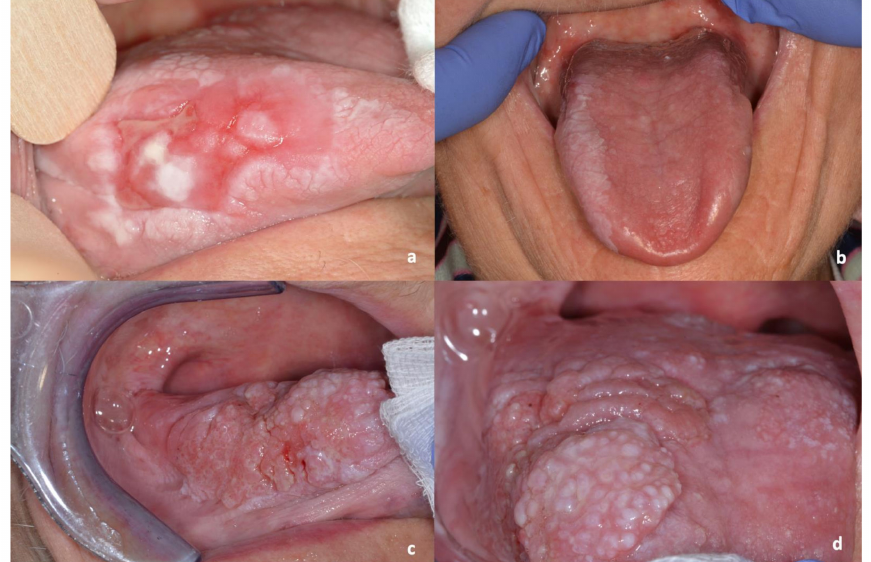
Figure 2. Evolution of OLP lesions on the right lateral border of the tongue and dorsum of the tongue of a female patient ( a = 2009; b = 2010; c and d = 2015, date of cancer